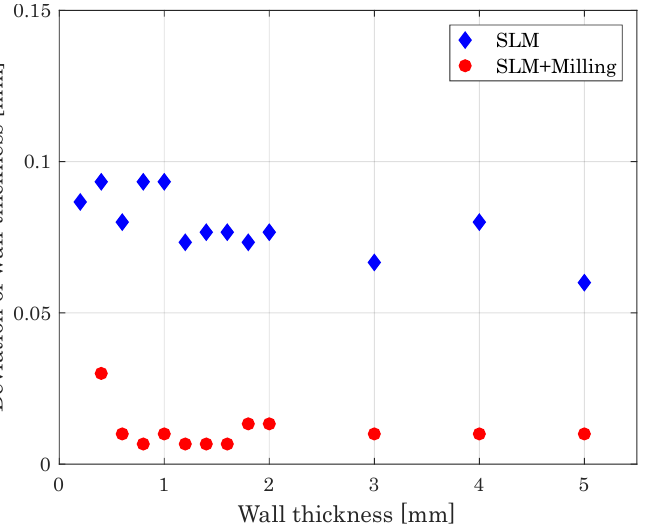
Figure 11. Deviation of wall thickness versus intended wall thickness, giving a measure of the dimensional accuracy of the